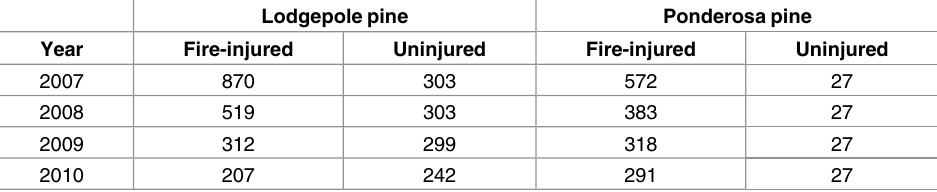
pole pine mortality after four years (Table 6). Combined mortality increased with the degree of fire injury for all measures (Fig 7), and any degree of fire injury increased the probability of mortality ( z = 12.089, P (cid:20) 0.001). Of the 198 strip-attacked lodgepole pines from 2007 to 2009, 78% were dead by 2010. Of the 159 uninjured trees that were attacked, 37% died by 2010, but only 18% died the year following attack. Table 6. Number of living fire-injured and uninjured lodgepole and ponderosa pines remaining each year. Lodgepole pine Ponderosa